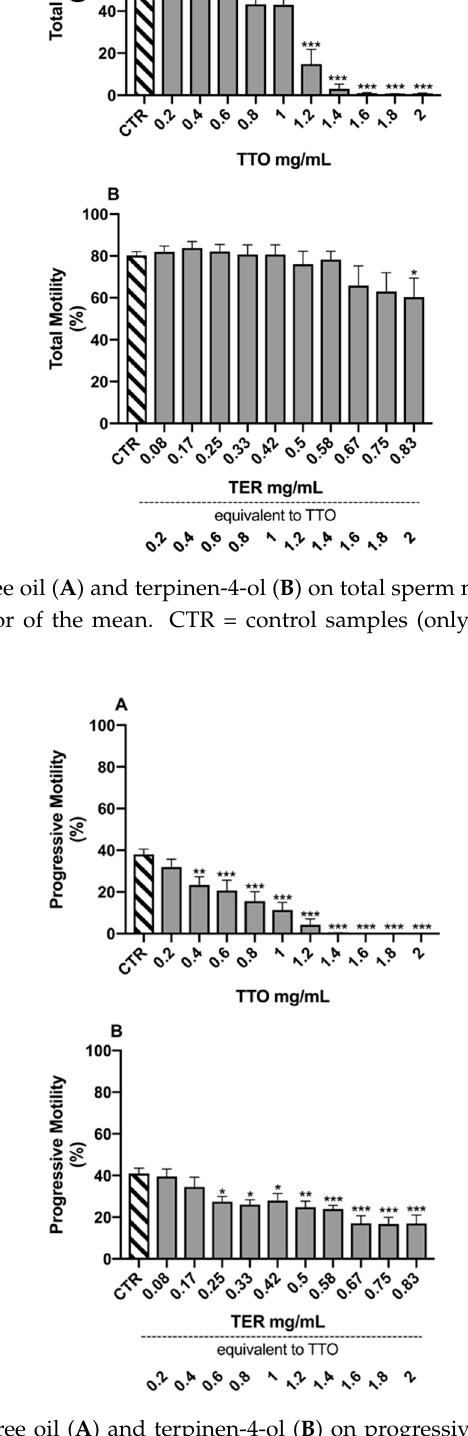
Figure 4. Effects of tea tree oil ( A ) and terpinen-4-ol ( B ) on progressive sperm motility. Data are expressed as mean ± standard error of the mean. CTR = control samples (only emulsifiers). * = p < 0.05; ** = p < 0.01; *** = p <